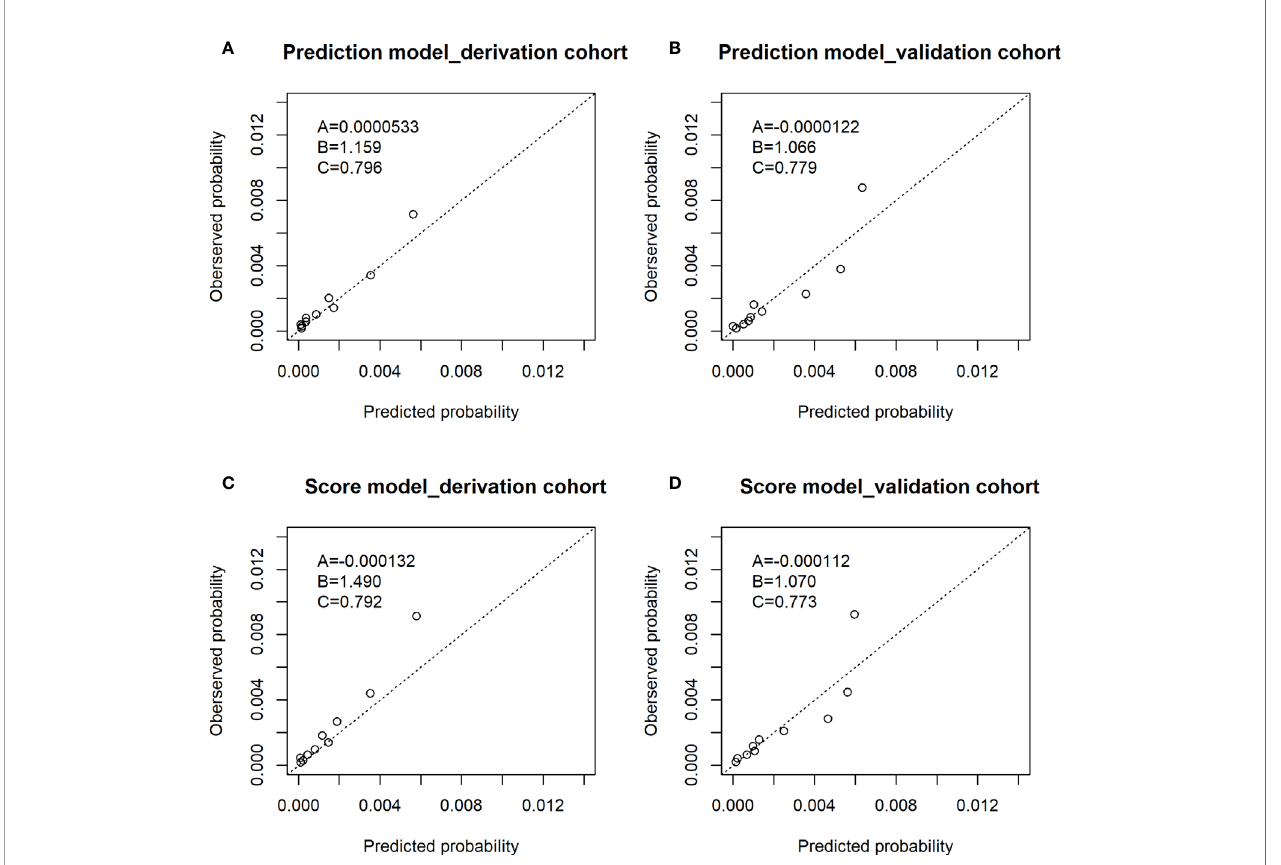
FIGURE 2 | Observed proportion of ESCC and predicted risk of ESCC within 5 years in the derivation cohort and validation cohort. (A) The calibration plot of prediction model of derivation cohort; (B) the calibration plot of prediction model of validation cohort; (C) the calibration plot of score model of derivation cohort;